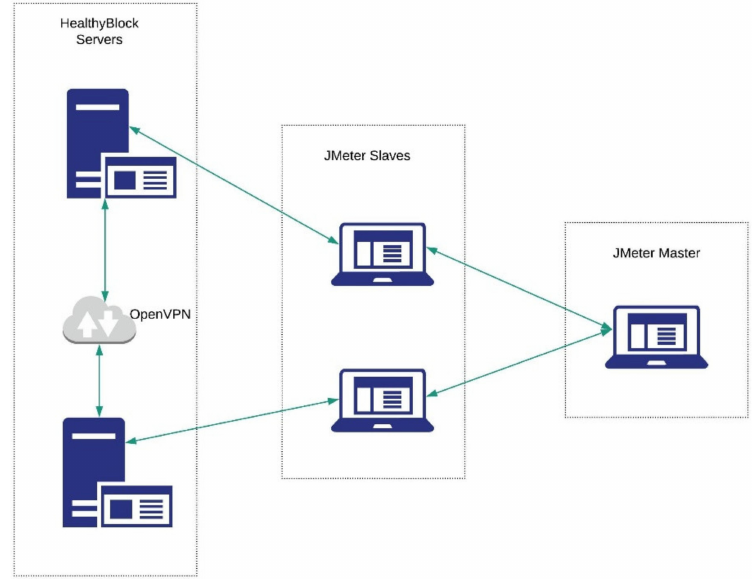
Figure 14. JMeter distributed configuration.